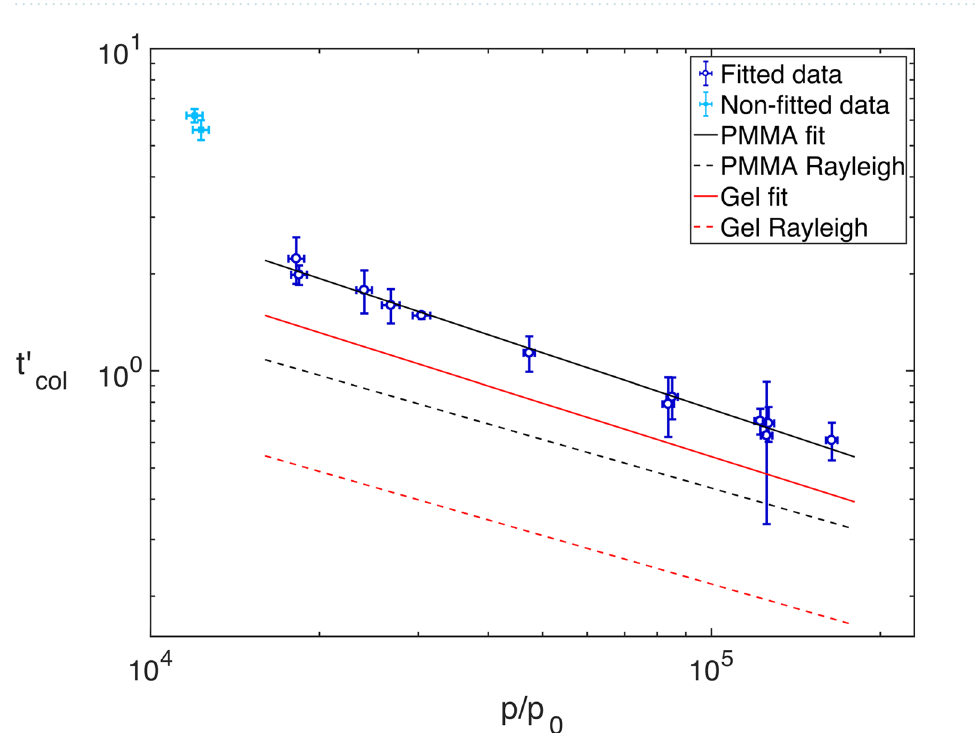
Figure 7. Logarithmic plot of ′ t vs. p / p 0 for shock-induced and Rayleigh collapse. The open circles show the col collapse times obtained from curve fitting and the closed symbols show the collapse times estimated from the 0 58 , and the solid red radiographs. The solid black line shows the fit for the data, with p > 1.25 GPa, ′ = − . t p p 617( / ) col 0 0 55 25 . The dashed black and red lines show line shows the fit from the Swantek & Austin study, ′ = − . t p p 305( / ) col SA , 0 0 5 , and water, ′ = − . t p p 69( / ) R 0 5 R the respective theoretical Rayleigh curves for PMMA, ′ = − . t p p 137( / ) col PMMA , 0 col gel , 0